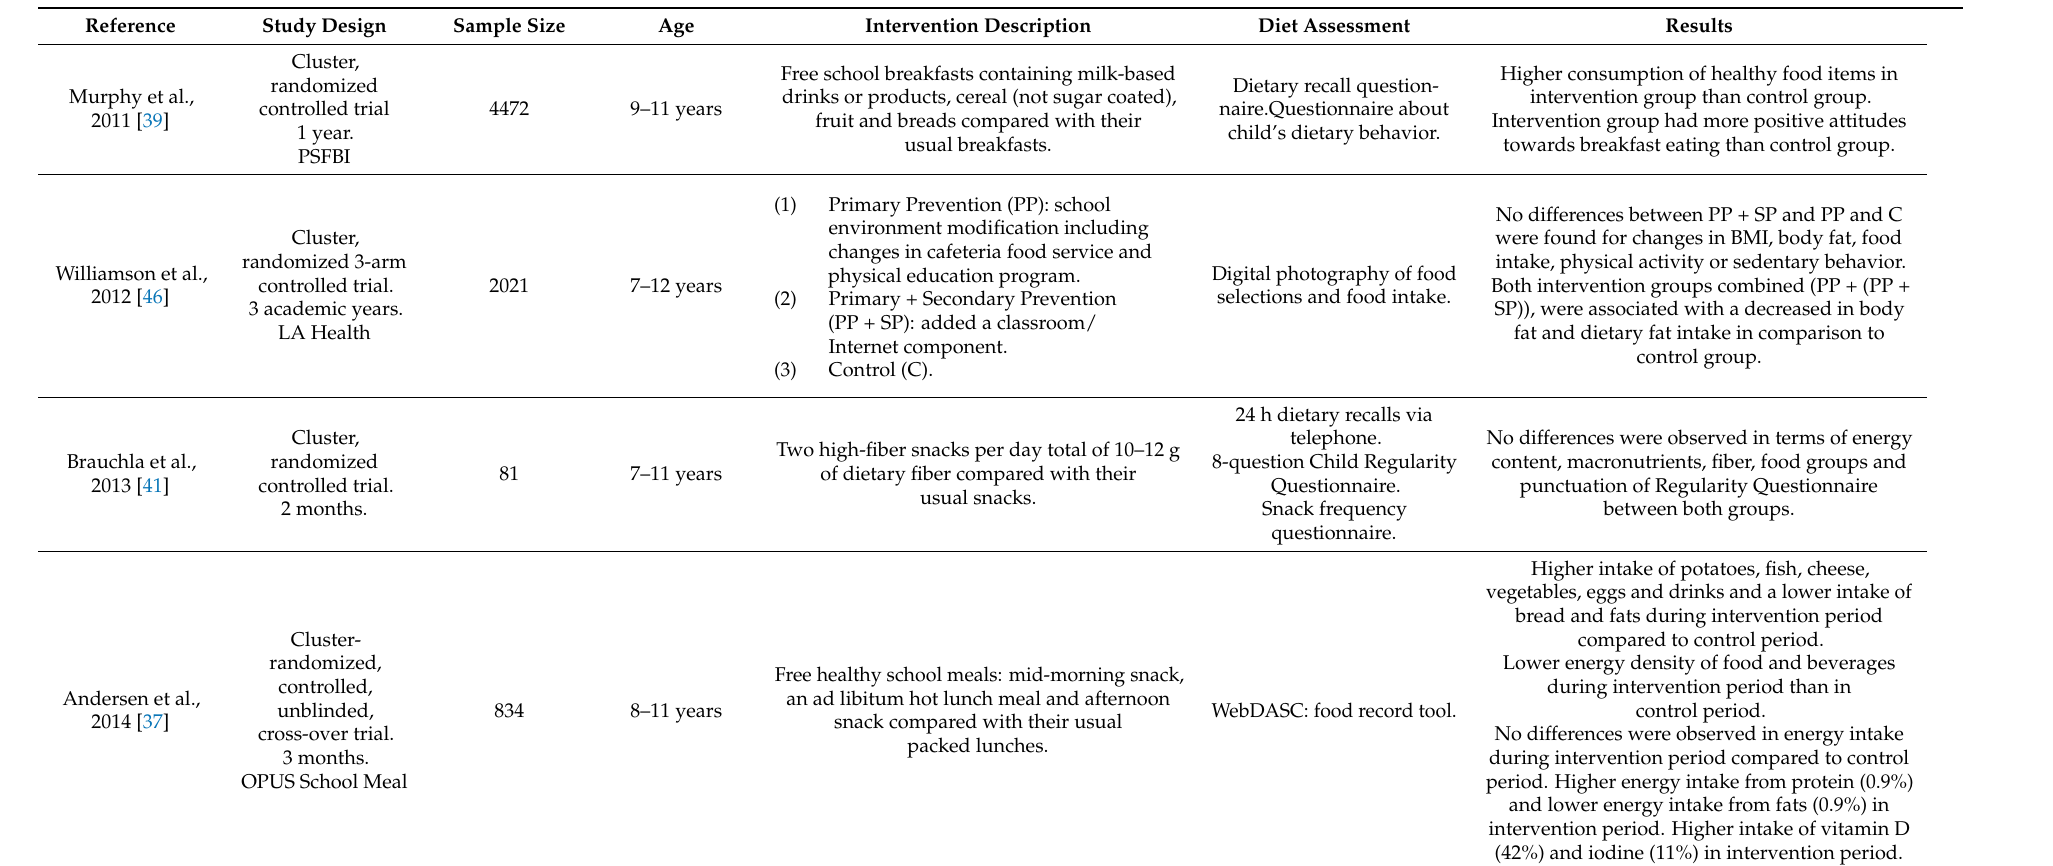
Table 1. Characteristics of the studies included in the systematic